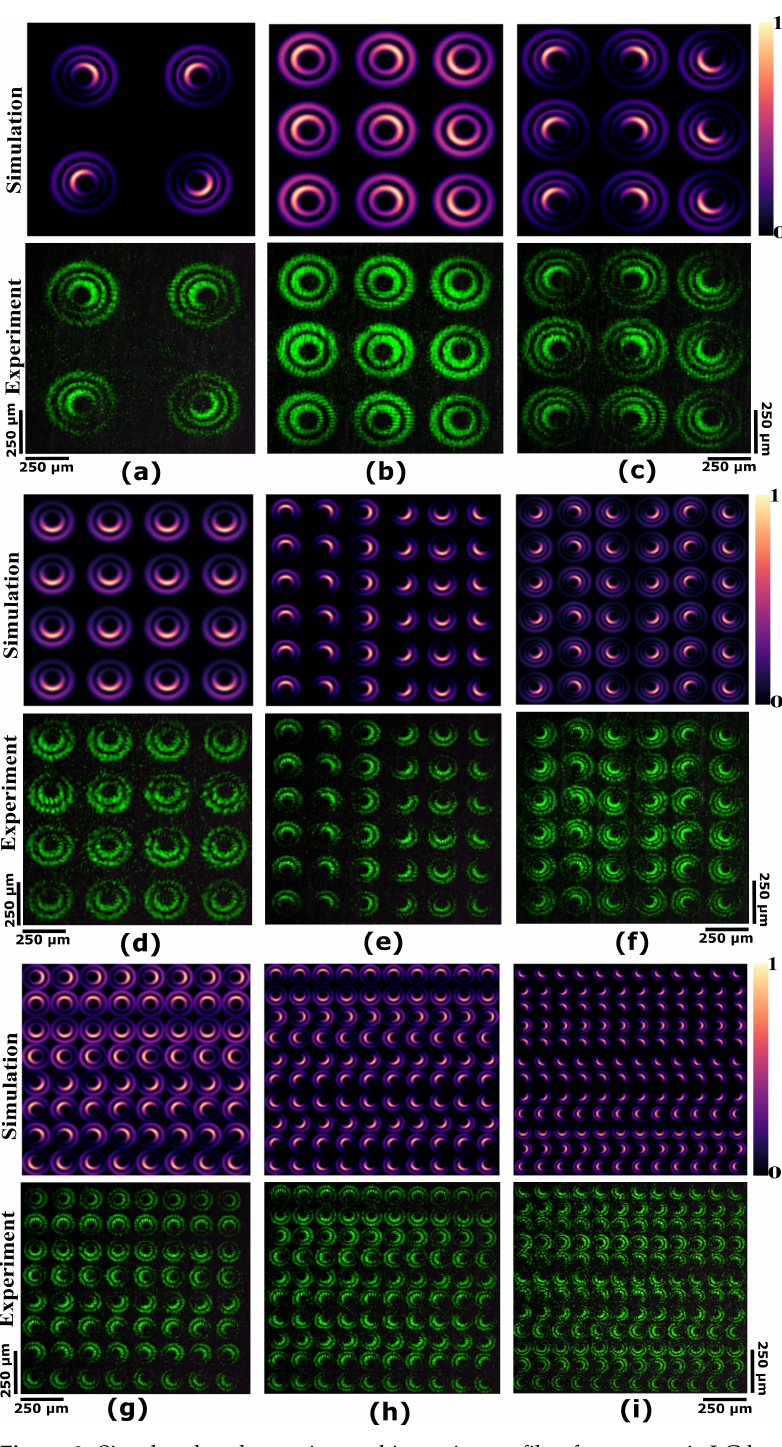
Figure 8. Simulated and experimental intensity profile of asymmetric LG beam array of different asymmetricity and array dimensions, ( a , c , f ) radial index = 2 and azimuthal index = 5, ( b , d , e , g , h , i ) radial index = 1 and azimuthal index =